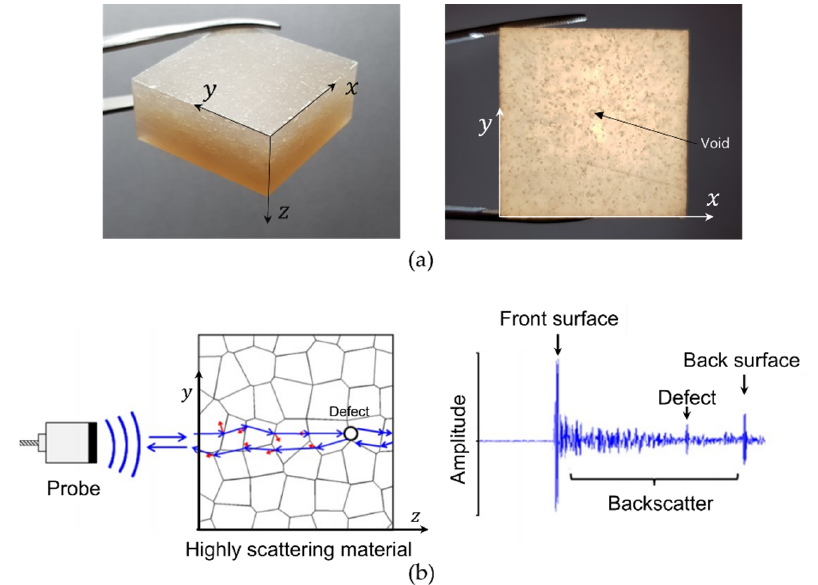
Figure 1. Ultrasonic NDT of composites: ( a ) sample of GFRP hull plate, and ( b ) high ultrasonic attenuation due to inhomogeneous properties of composites; reprinted with permission from ref. [10]. 2015 Van Pamel.